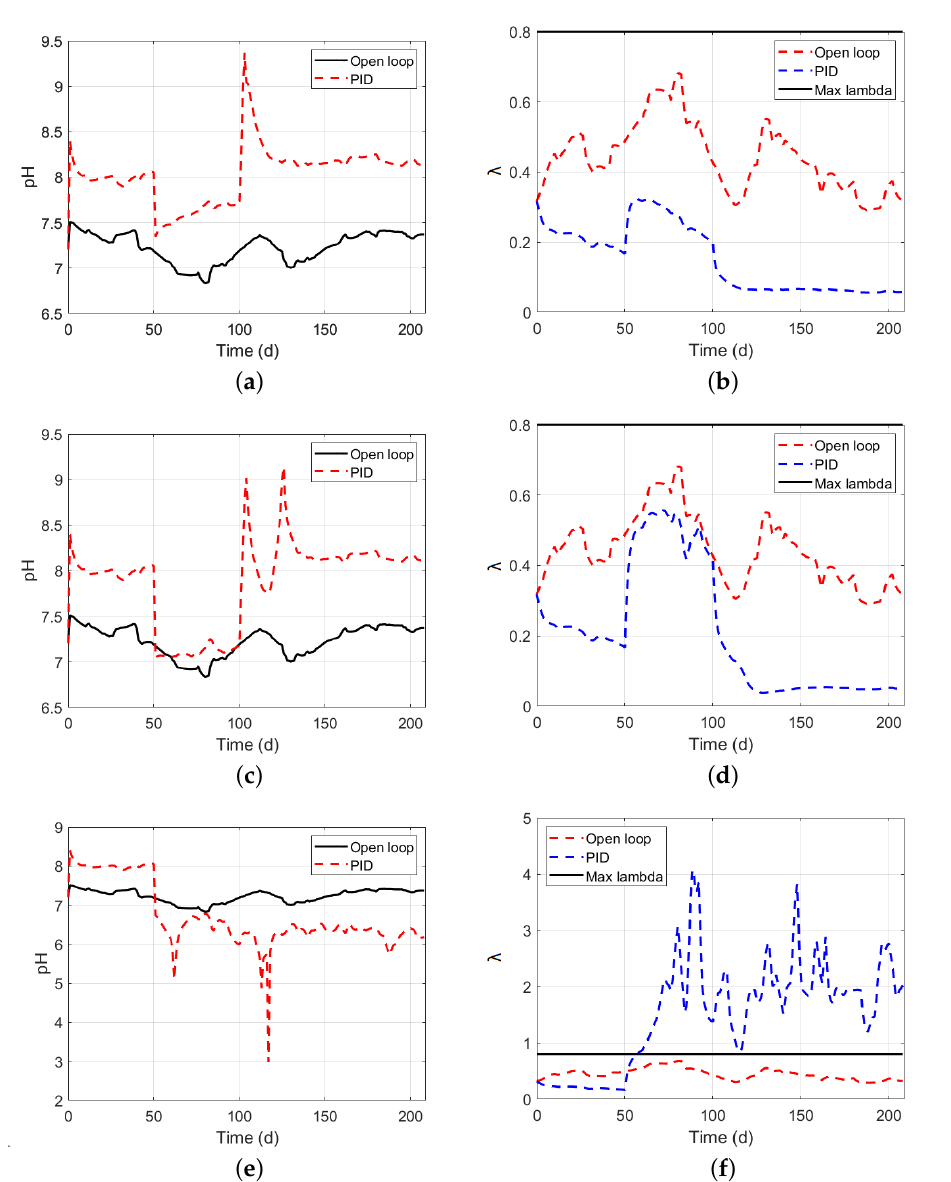
Figure 6. Performance of PID controller after step changes. ( a ) pH values after a low change in CH 4 ; ( b ) λ values after a low change in CH 4 ; ( c ) pH values after a medium change in CH 4 ; ( d ) λ values after a medium change in CH 4 ; ( e ) pH values after a high change in CH 4 ; ( f ) λ values after a high change in CH 4